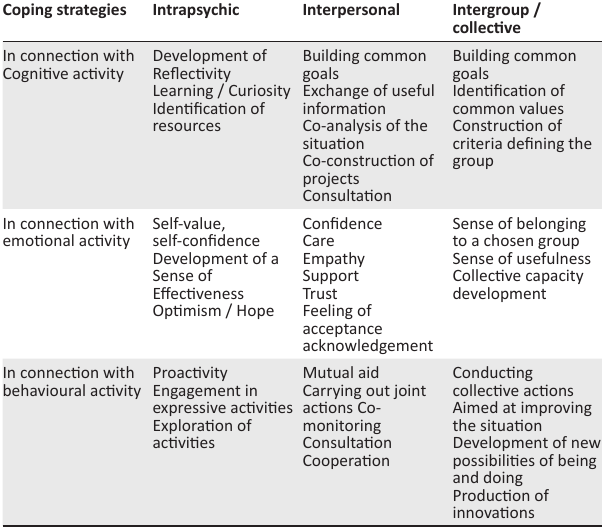
TABLE 1 : Cognitive, Emotional, and behavioural activities supporting the development of three sets of coping strategies amongst students, to face identity threat during the pandemic